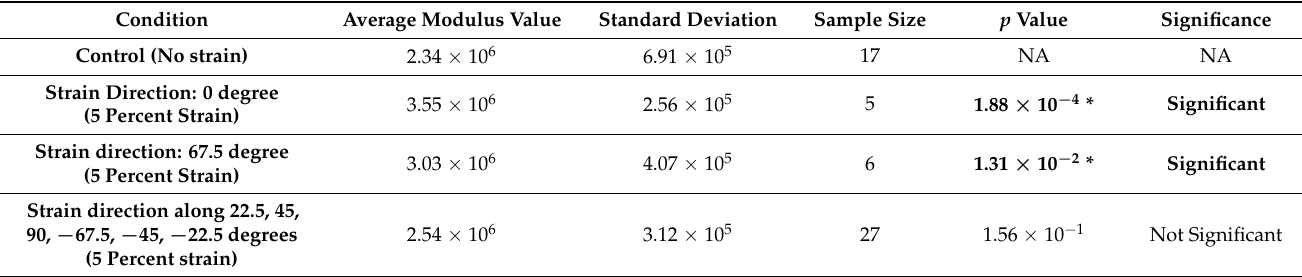
Figure 4. Elastic modulus in MPa of skin versus angle in degrees measured at a strain of 5% in vivo using VOCT. The angle at zero degrees is defined arbitrarily as the angle where the maximum elastic modulus occurs. The moduli measured at 0 ◦ and 67.5 ◦ are significantly higher than the moduli at all other angles at 5% strain (see Table 2). While under physiologic conditions the collagen fibers in skin are more randomly oriented within the plane of the skin, under external loads the fibers appear to orient at 0 ◦ and 67.5 ◦ . Table 2. Statistical analysis using a 2 tailed t -test of the angular dependence of the modulus of skin (Figure 4). The 0 ◦ angle defined as the angle where the maximum modulus is measured. Only the moduli at 0 ◦ and 67.5 ◦ at 5% strain are significantly different than that of the unstretched